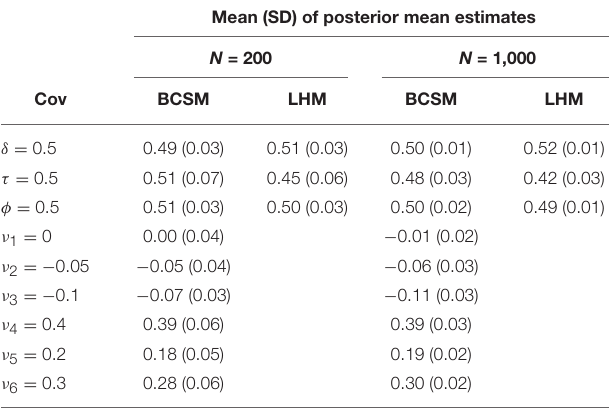
TABLE 7 | Means and standard deviations of posterior mean estimates across 100 simulated replications of data for 200 and 1,000 test-takers and 12 items. Mean (SD) of posterior mean